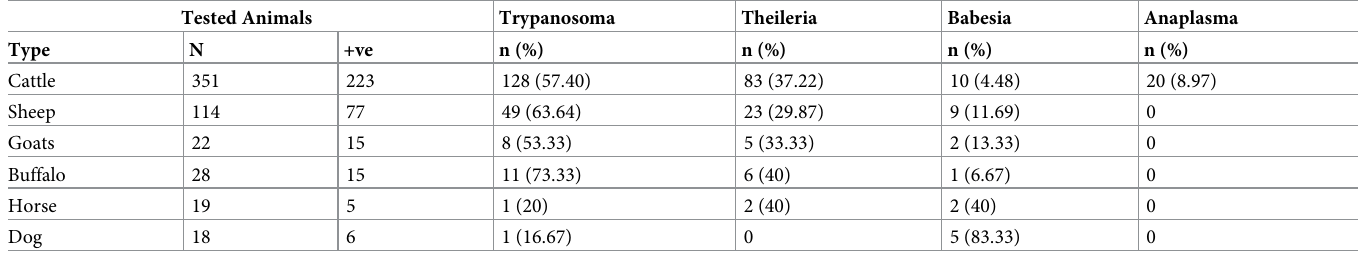
Table 1. Distribution of blood parasites according to the type of animal using blood smears tested at the Veterinary Teaching Hospital | University of Mosul between Oct 30, 2017 to Dec 31, 2019. Tested Animals Trypanosoma Theileria Babesia Anaplasma Type N +ve n (%) n (%) n (%) n (%) Cattle 351 223 128 (57.40) 83 (37.22) 10 (4.48) 20 (8.97)